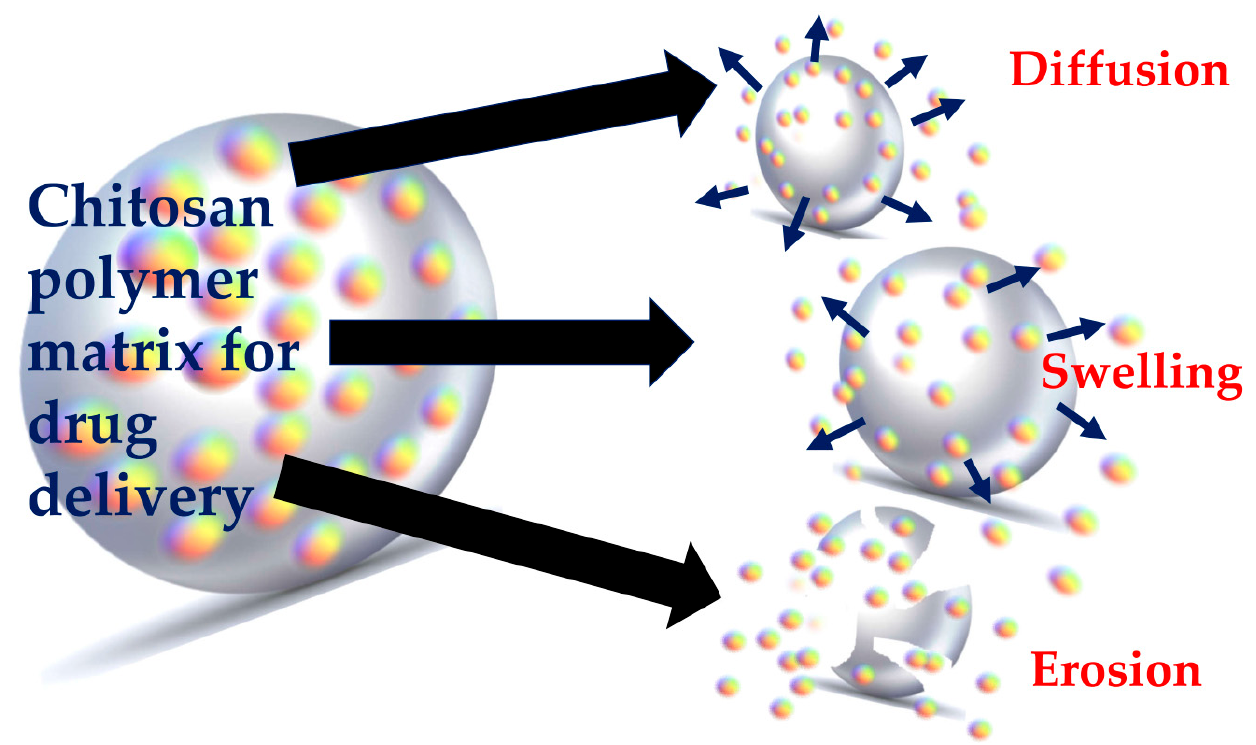
Figure 1. The predominant three processes involved in chitosan polymer-based drug delivery.